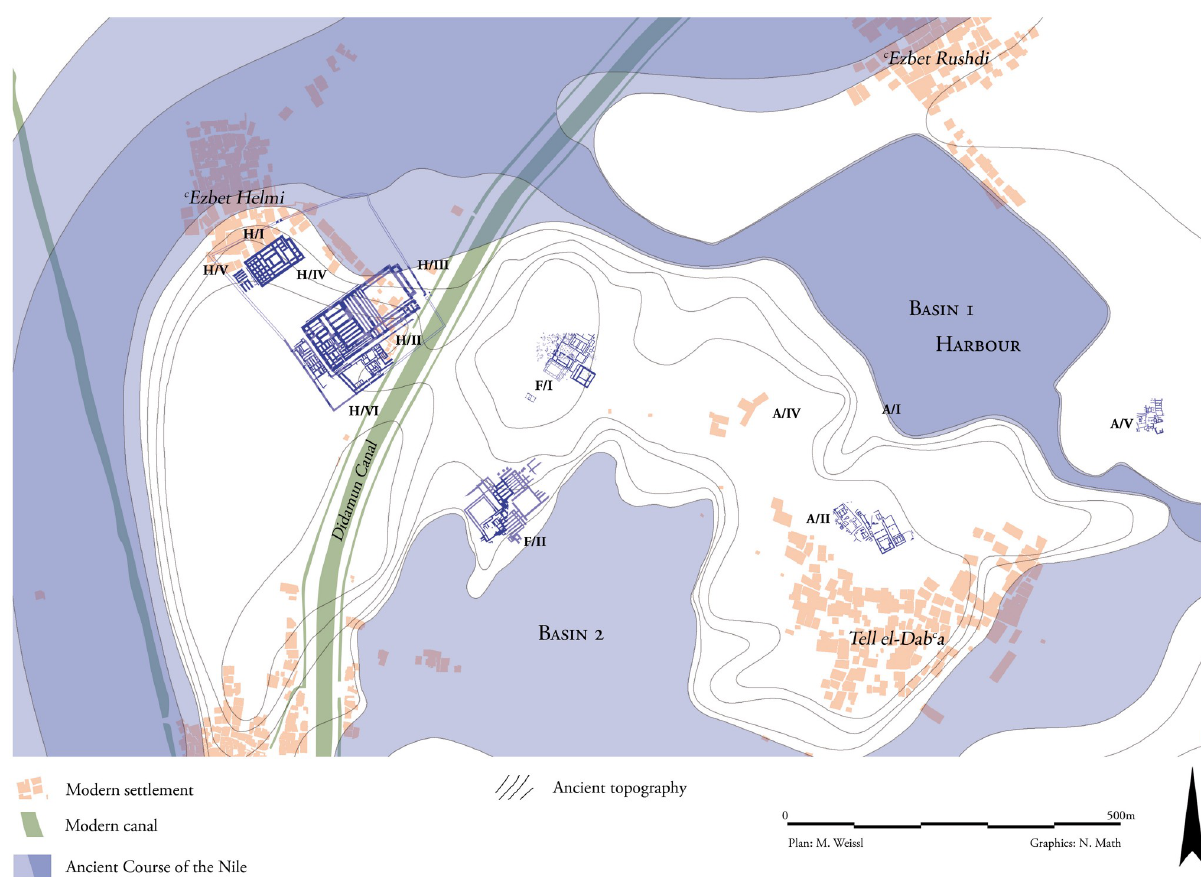
Fig 2. Site plan of Tell el-Dab c a and nearby sites of ʿ Ezbet Helmi and ʿ Ezbet Rushdi.